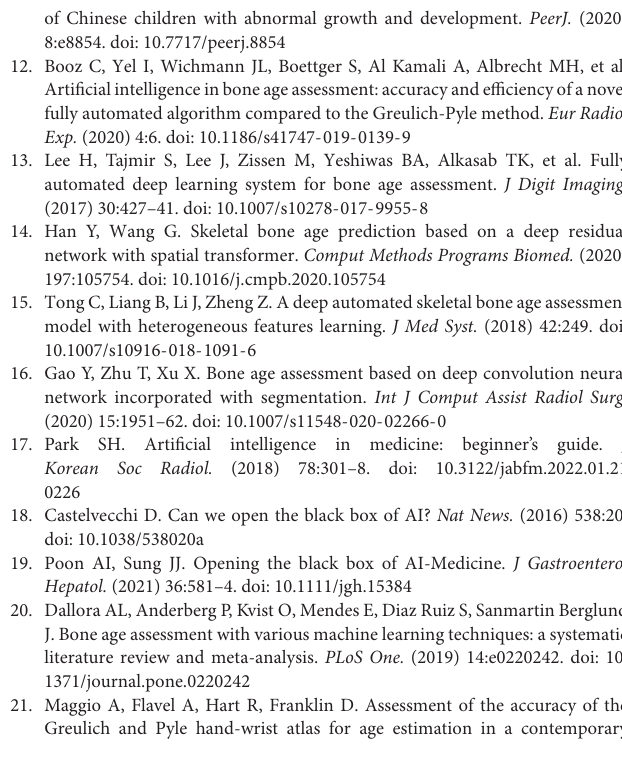
Supplementary Figure 1 | The Bland-Altman plot for EFAI-BAA vs. KVGH (#1). Supplementary Figure 2 | The Bland-Altman plot for EFAI-BAA vs. TVGH2 (#2). Supplementary Figure 3 | The Bland-Altman plot for EFAI-BAA vs. TZUCHI-TP